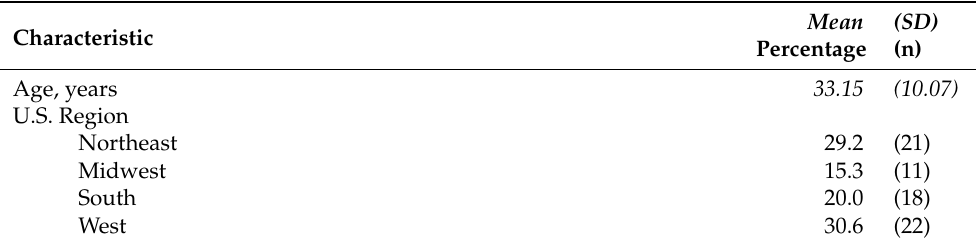
Table 1. Sample demographic